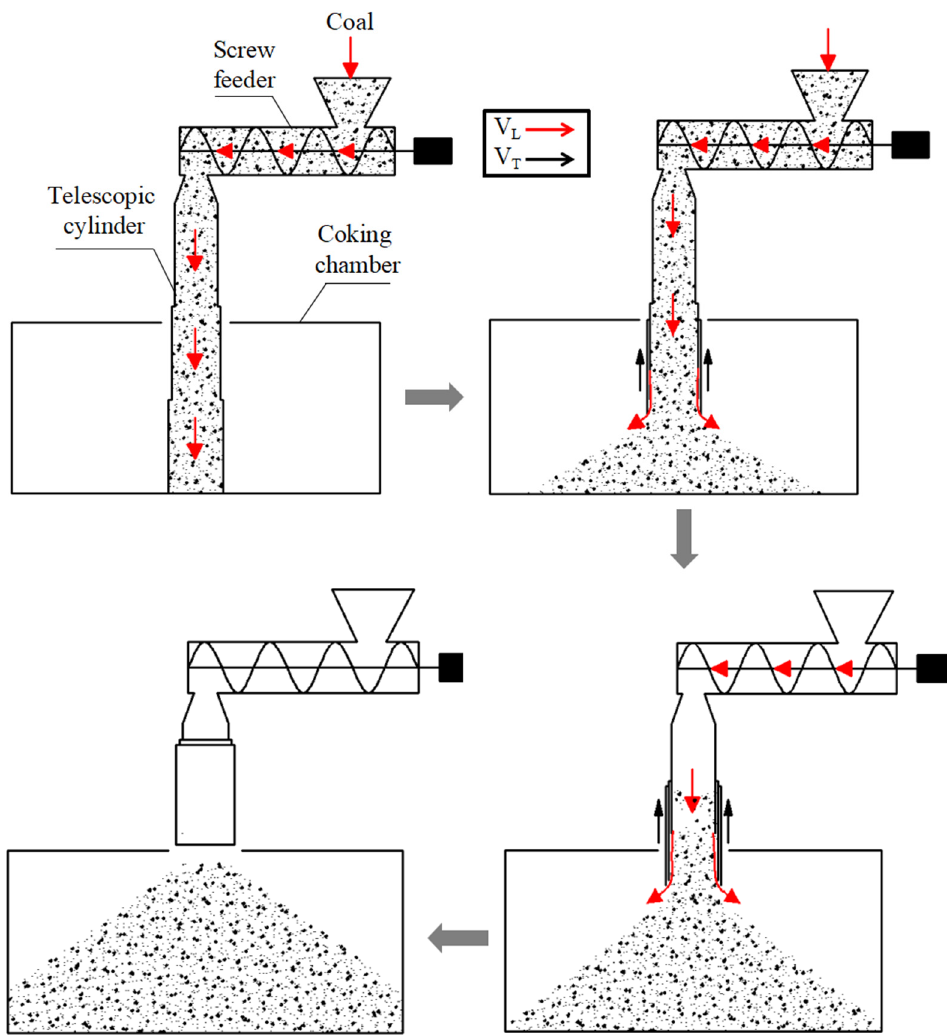
Figure 4. Operating principle of new coal charging equipment.